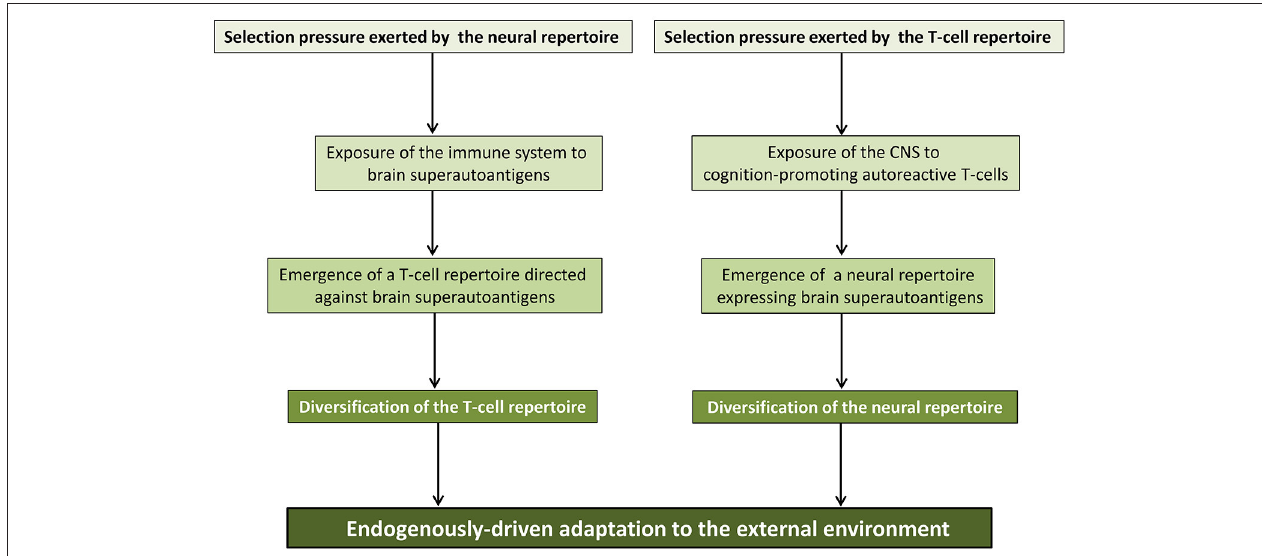
FIGURE 4 | Co-evolution/co-development of the neural and immune repertoires. The co-development/co-evolution model proposes that during evolution, neural and T-cell repertoires have exerted mutual selection pressures. In one hand, the T-cell repertoire directed against brain superautoantigens may have favored the emergence of a neural repertoire expressing brain superautoantigens. On the other hand, the neural repertoire expressing brain superautoantigens may have favored the emergence of a T-cell repertoire directed against brain superautoantigens. As a result, evolution of the immune and nervous systems, the two main systems allowing the sensing of and adaptation to the external environment would have been, at least in part, endogenously-driven. This figure is reproduced with permission and slight modifications from the chapter “Brain superautoantigens: connections between immune and neural repertoires” published in the e-book “Brainimmune” (Nataf, 2017a).